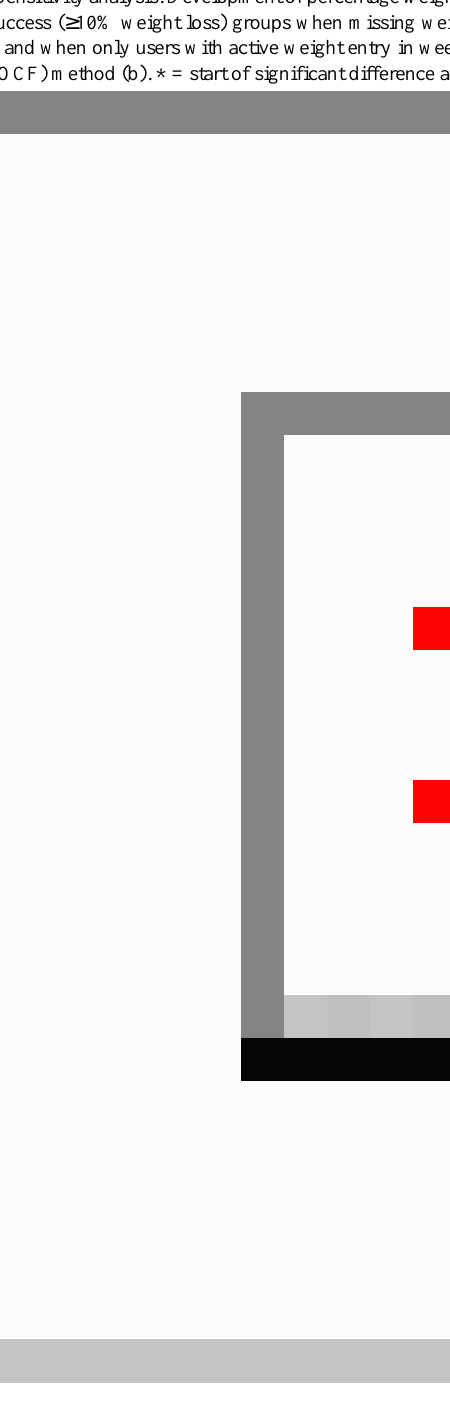
Figure 6. Sensitivity analysis. Development of percentage weight loss in the unsuccessful (<5% weight loss), moderate success (5%-9.9% weight loss), and high success ( ≥ 10% weight loss) groups when missing weight data in the study sample were imputed using the baseline carried forward (BCF) method (a) and when only users with active weight entry in weeks 25-26 were included and missing data were imputed using last observation